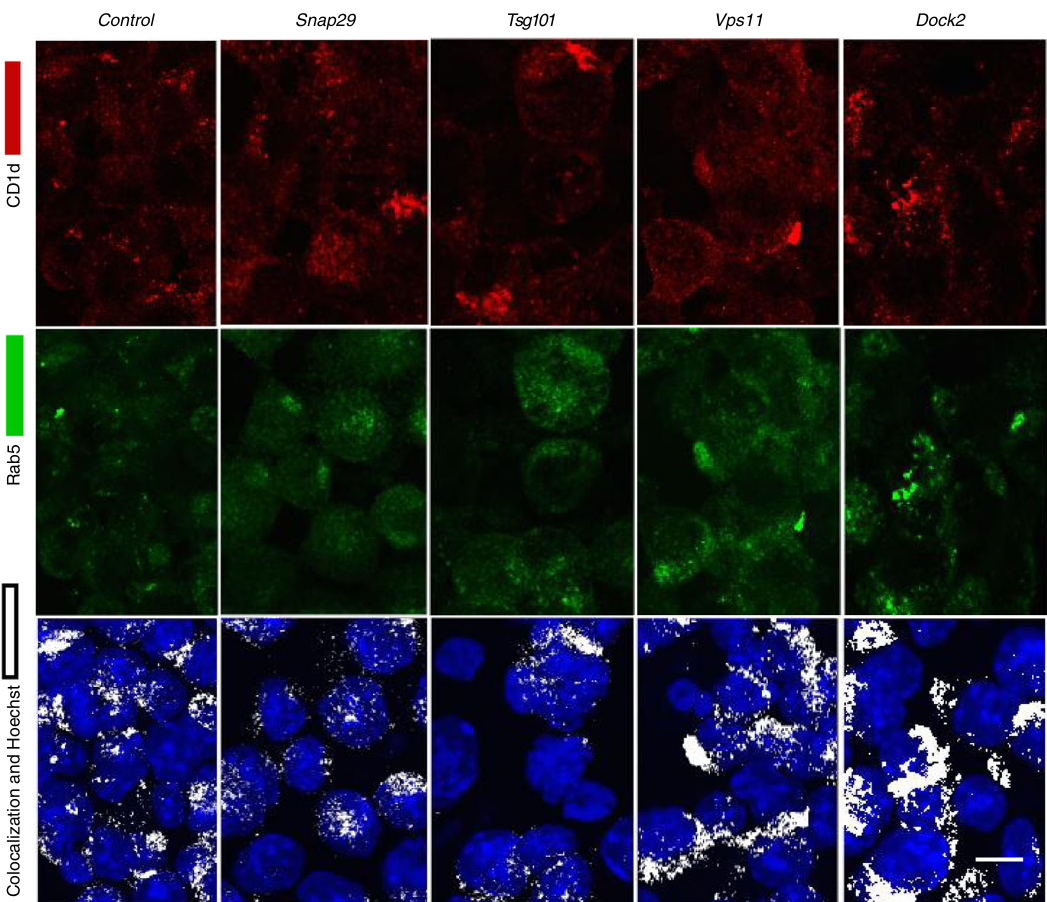
Fig. 7 Effects on localization of CD1d to early endosomes. Representative images for CD1d and Rab5 co-localization after knockdown of the indicated genes in J774-CD1d cells. Representative data from one of two experiments in which at least 200 cells per condition were analyzed. Scale bar 10 μ m. See also Supplementary Fig.